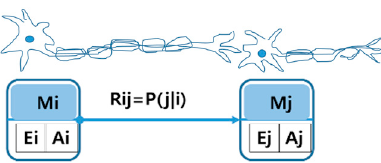
Figure 6. Memory Capsule and the connection link R ij between M i and M j .